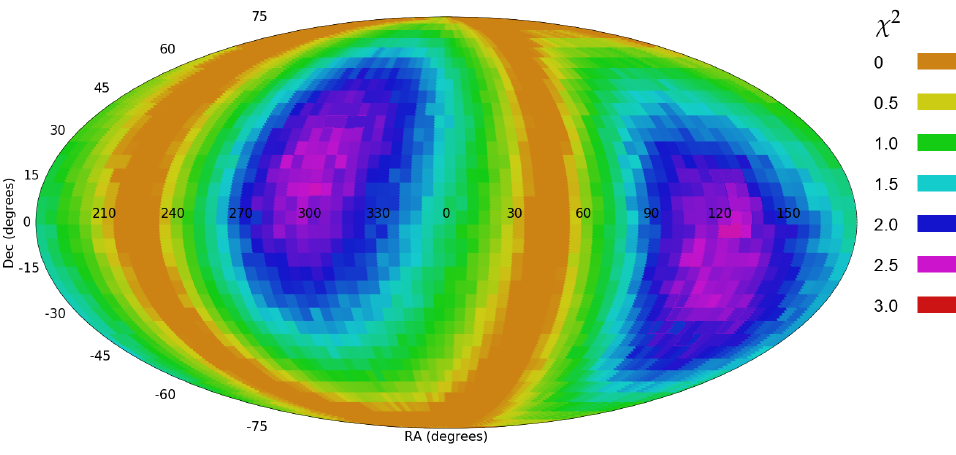
Figure 9. The χ 2 probability of the dipole axis when the dataset in limited to galaxies with exponential g magnitude of less than 18.